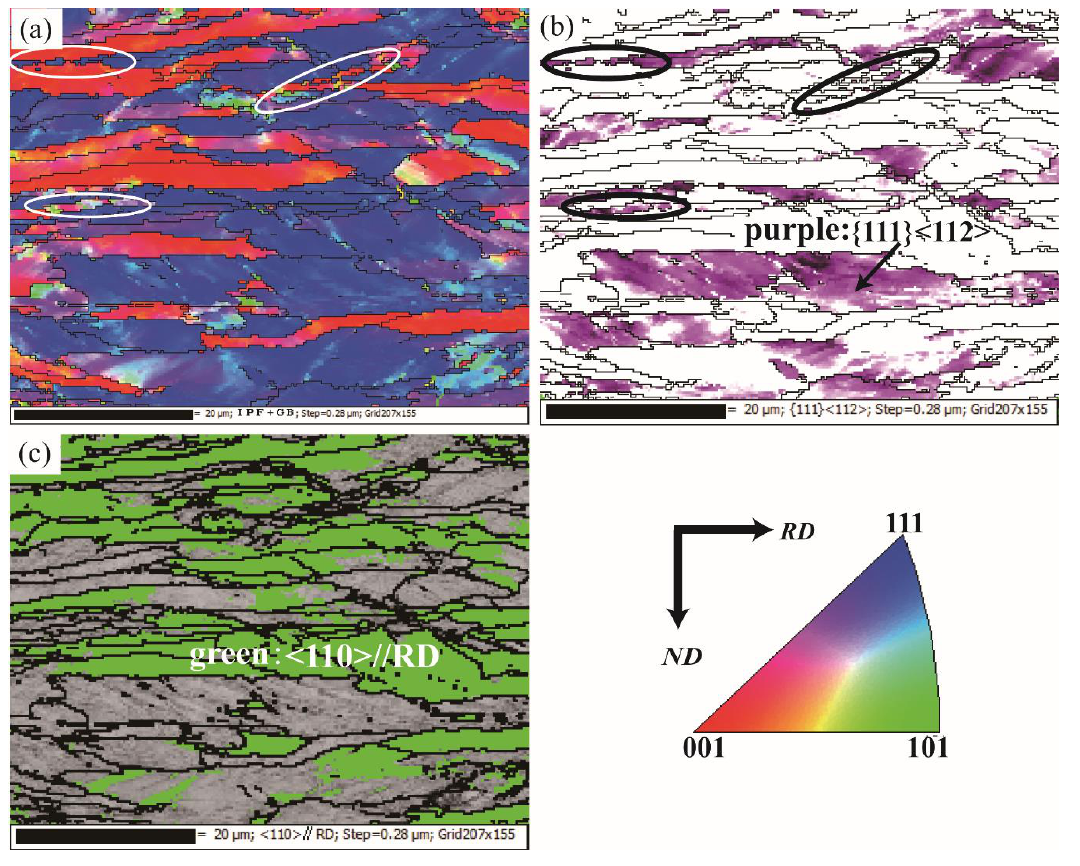
Figure 9. Orientation distribution of the warm-rolled texture. ( a ) Transitional band and {111}<112> grains; ( b ) 350°C IPF (inverse pole figure); and (c) <110>//ND grain distribution.